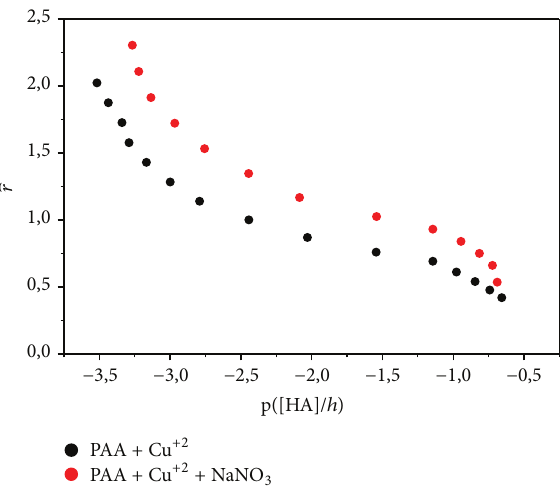
_ 𝑟= f ( p ([ HA ]/ℎ)) for PAA/Cu(II).